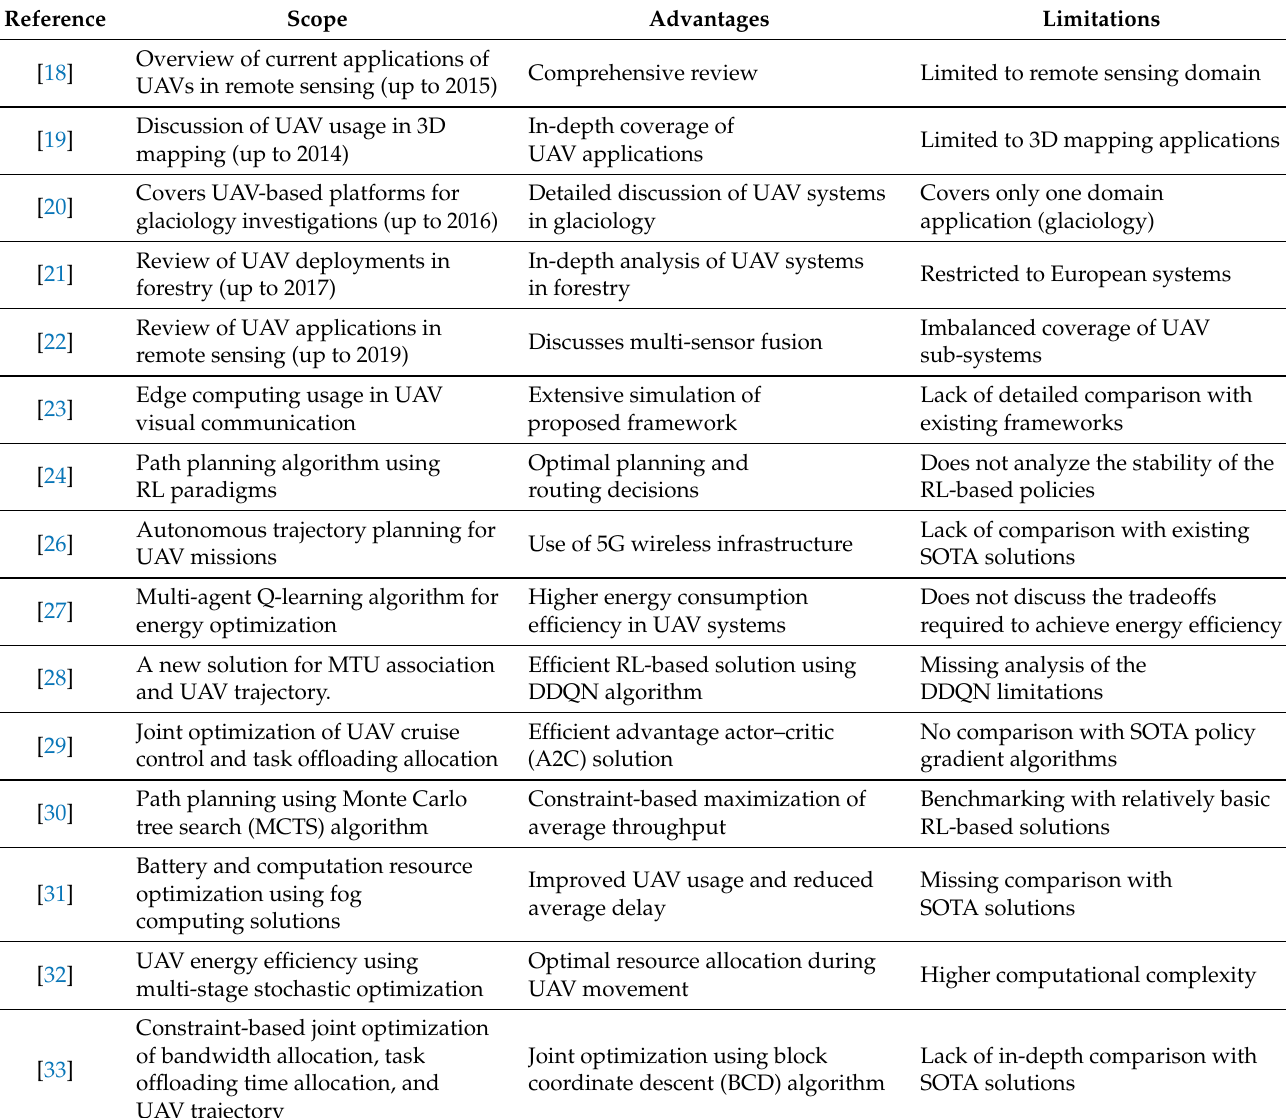
Table 1. Comparative analysis of related